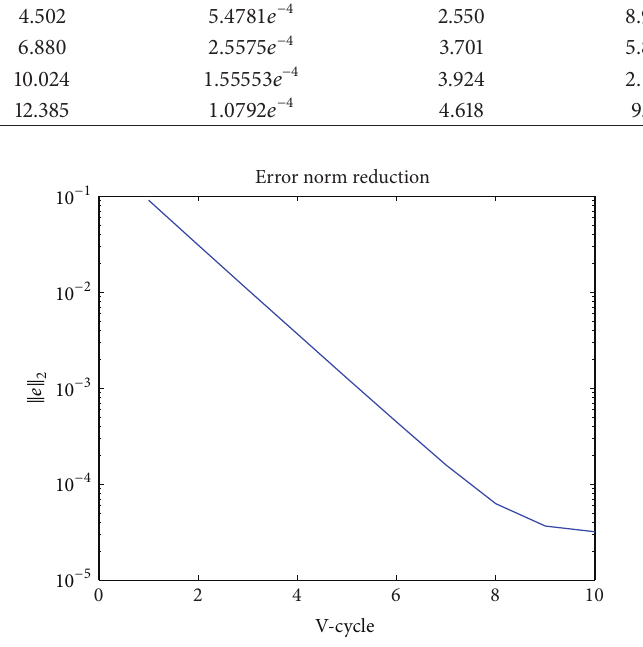
Figure 3: The error graph. The error vector 𝑒 𝑖𝑗 = 𝑢 𝑖𝑗 − V 𝑖𝑗 and 𝑁 = 6 are the number of nodes and ℓ = 10 for Example 3.